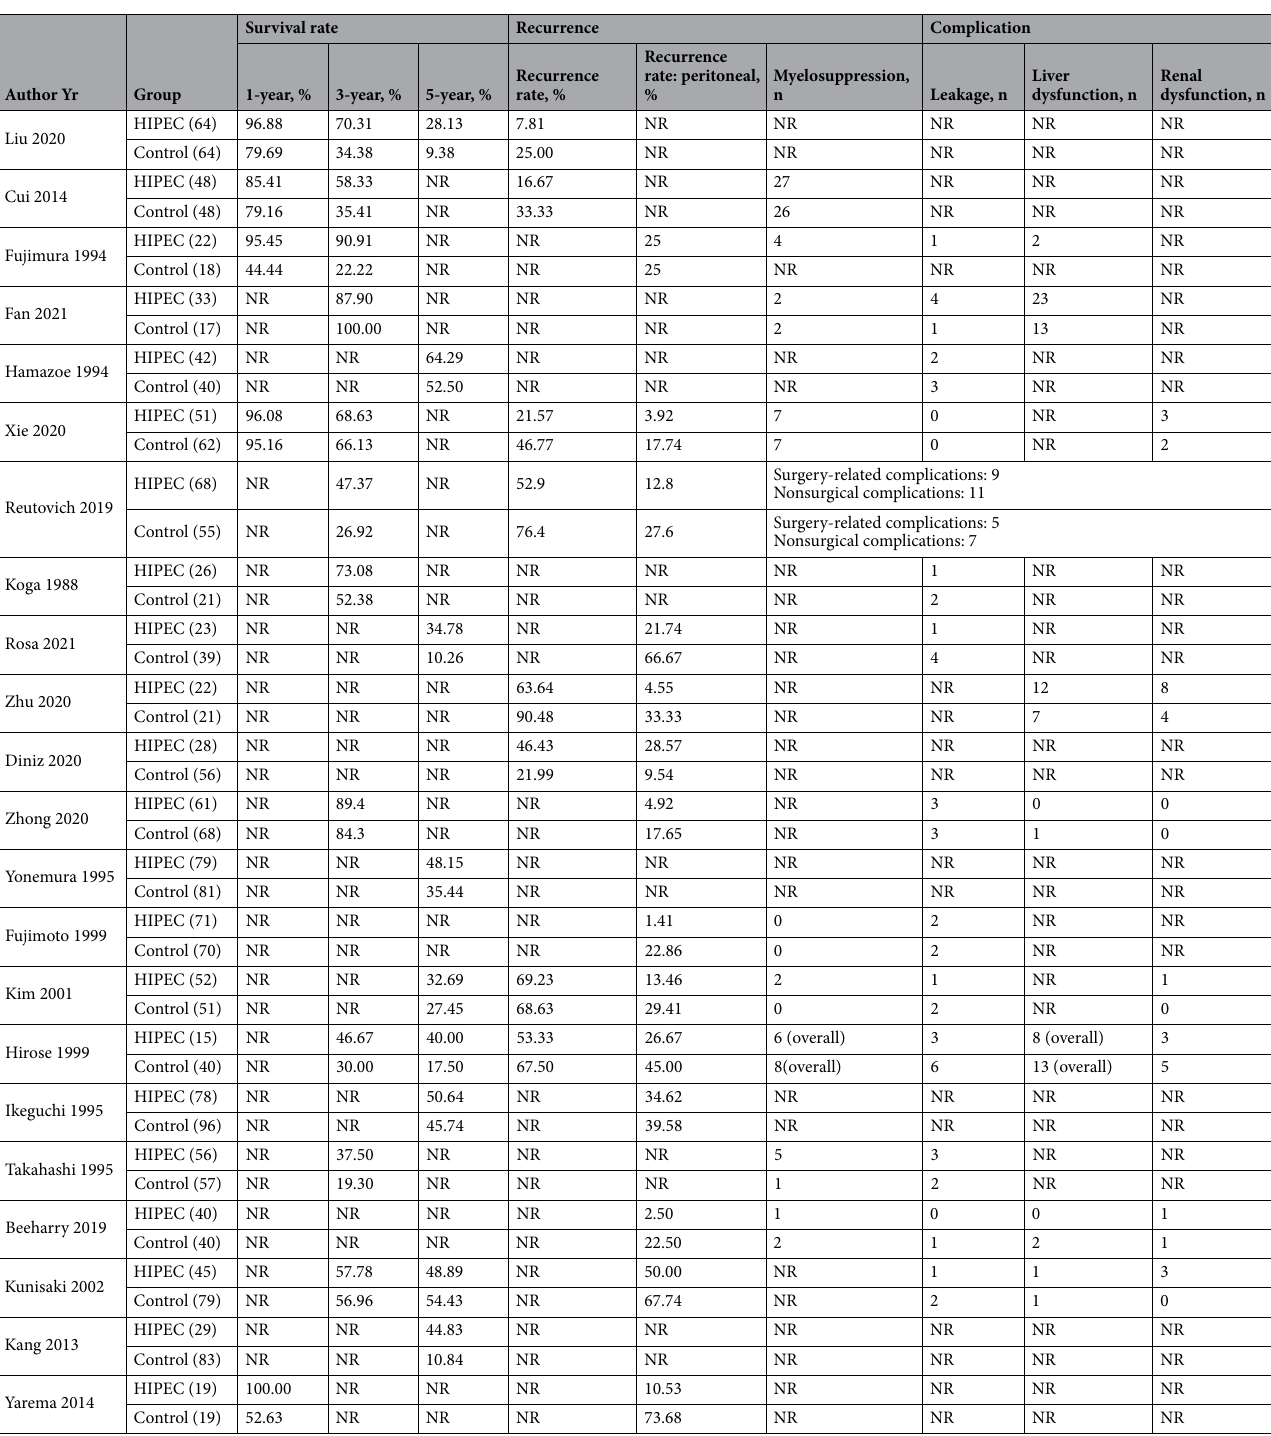
Table 5. The patients’ prognosis and response to treatment in the 22 eligible studies. HIPEC hyperthermic intraperitoneal chemotherapy, NR not record, Yr